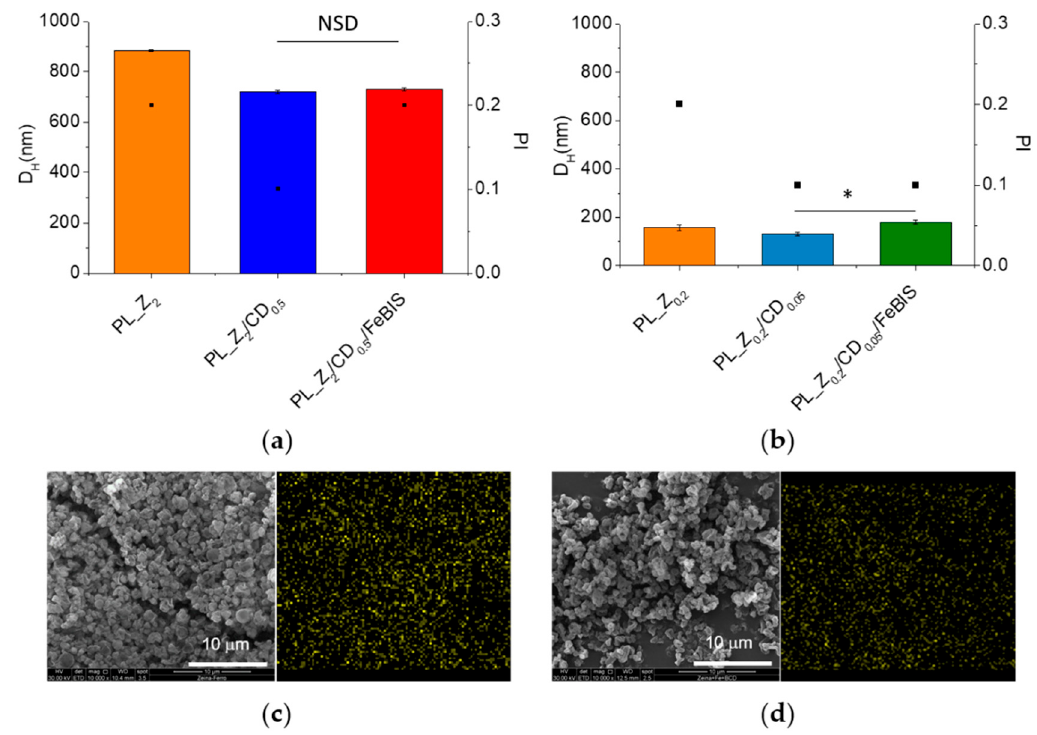
Figure 4. D H (bars) and PI (squares) of the pseudolatex employed to prepare powders at FeBIS theoretical loading of 2% ( a ) and 8% w / w ( b ). SEM images and corresponding energy dispersive X-ray (EDX) mapping of iron (yellow) in the MP_Z 2 / CD 0.5 / FeBIS ( c ) and MP_Z 0 . 2 / CD 0.05 / FeBIS ( d ). NSD: no significant difference. * p < 0.02.